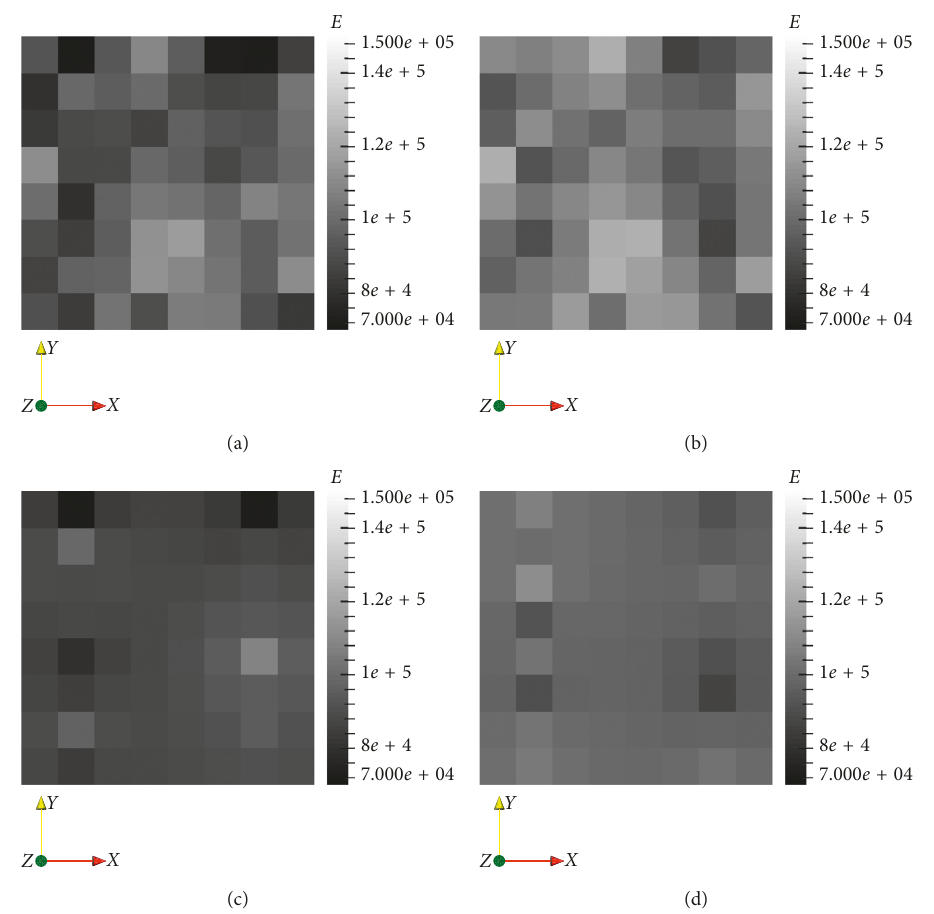
Figure 4: Example realisation i for unconditional field (a), conditional field (b), kriged field based on random field values at measurement locations (c), and kriged field based on measurement values (d), 2